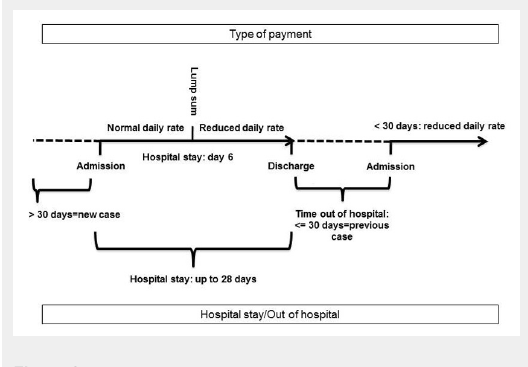
New Remuneration System (NRS): Illustration by several inpatient